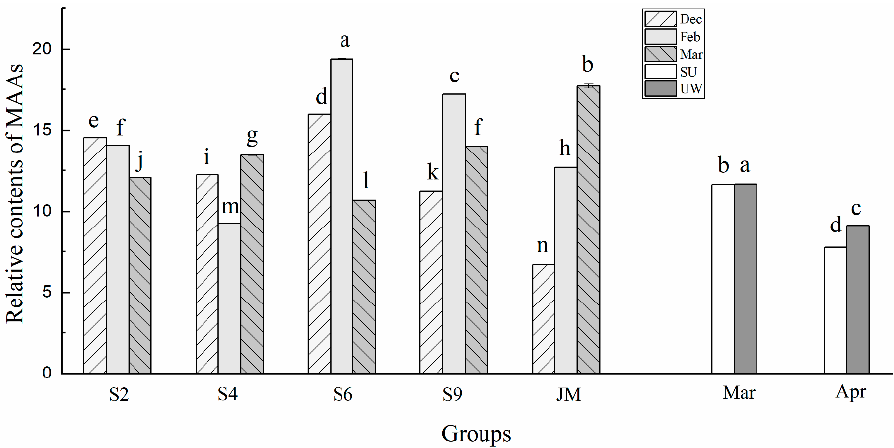
Figure 4. MAAs variations in N. yezoensis collected from different sites and cultivation periods. Data represent the mean ± SD ( n = 3). Different letters indicate a significant difference ( p < 0.05).